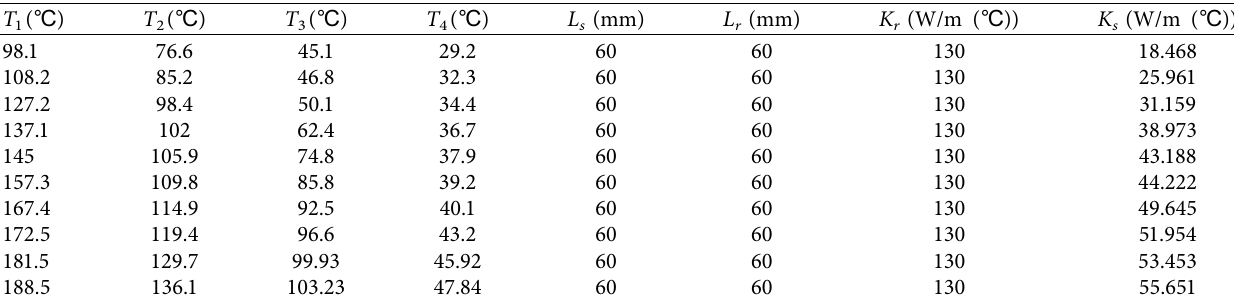
Table 6: Thermal conductivity (W/m ℃ ) of Ni-Cu +6% TiO